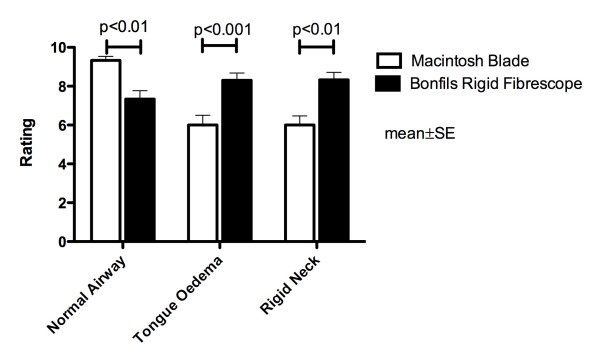
Rating of both techniques in the three scenarios. 10 = extremely easy, 0 = extremely difficult.